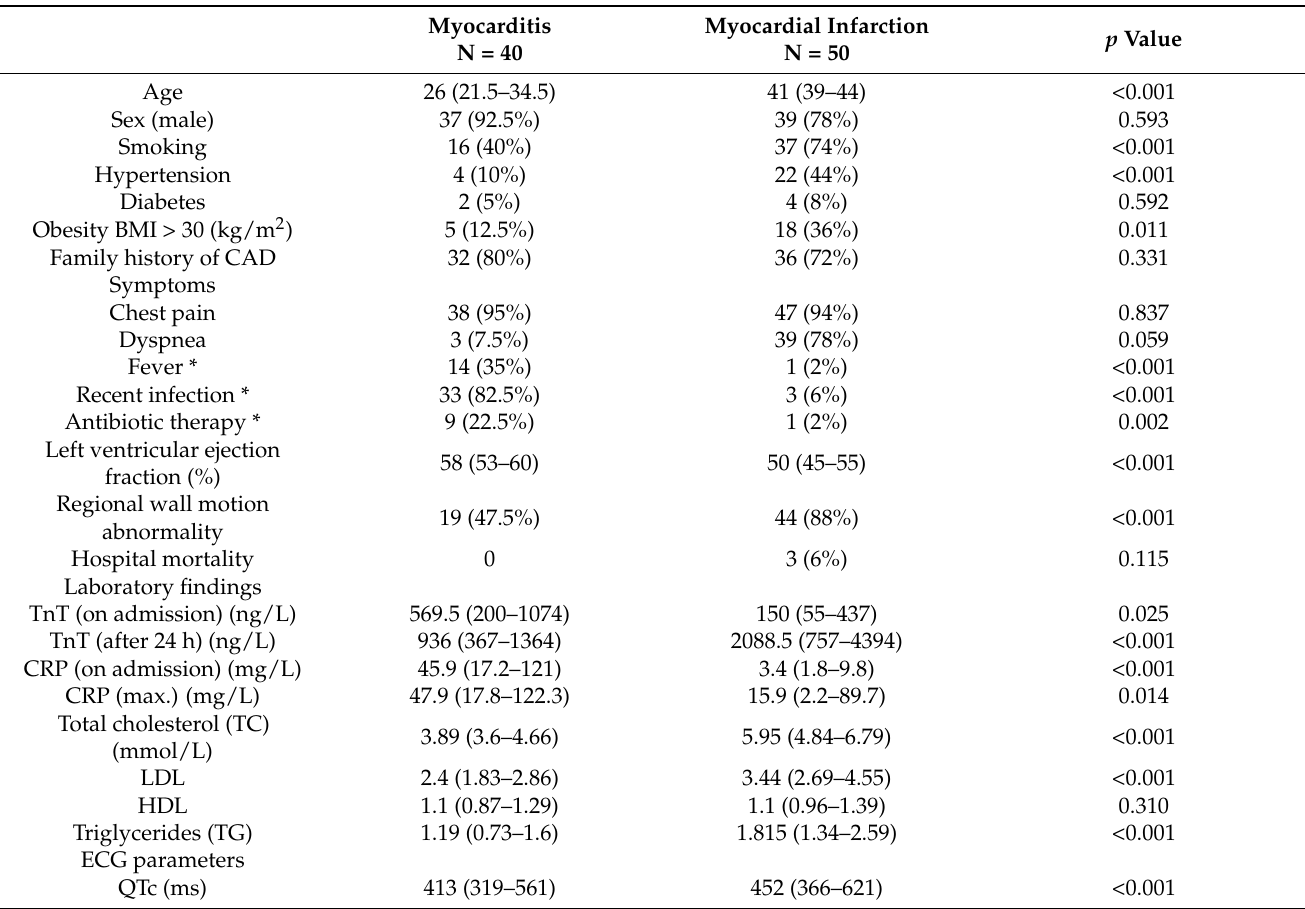
Table 2. Baseline